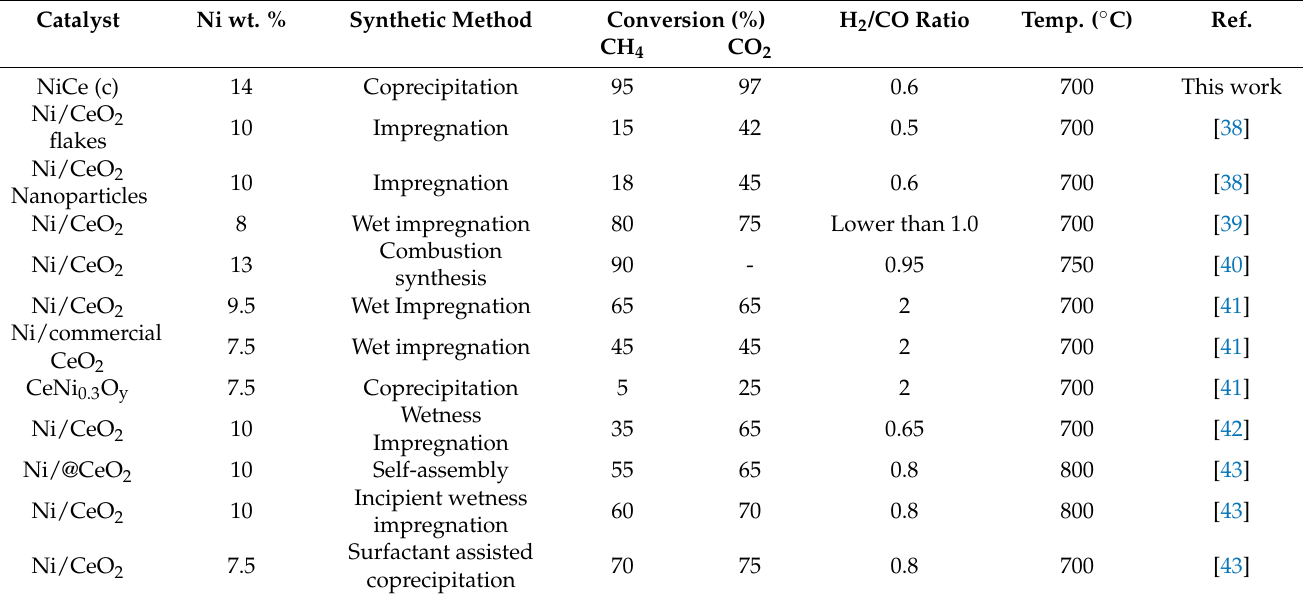
Table 3. Activity in terms of CH 4 and CO 2 conversion of Ni/CeO 2 catalysts, prepared with different methods and similar amount of Ni. The data refer to the start of